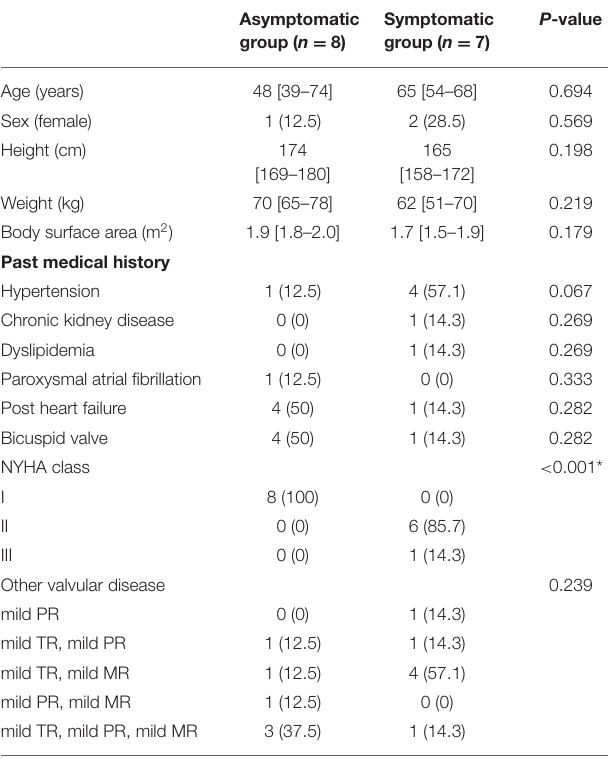
TABLE 1 | Patients’